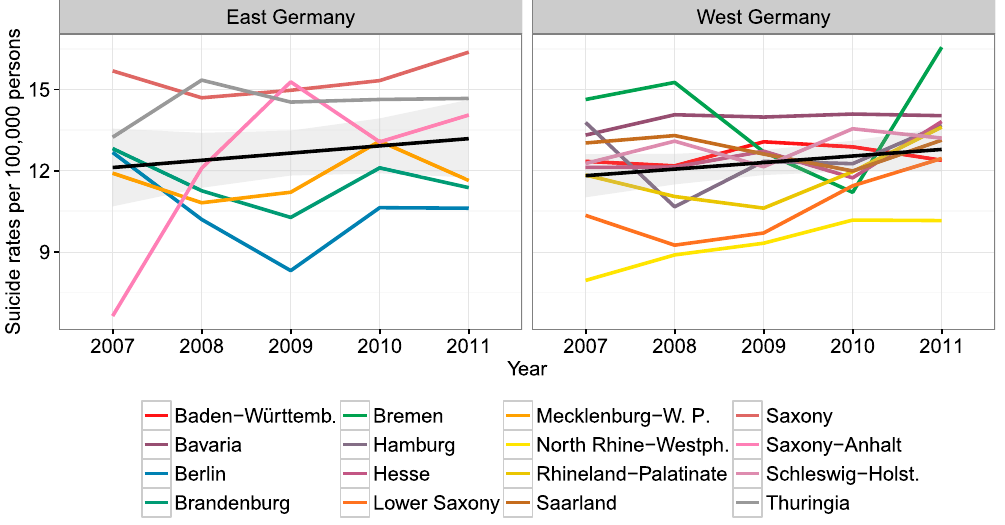
Figure 1. Suicide rates 2007–11 per federal state (the black line shows the temporal trend together with the 95% confidence